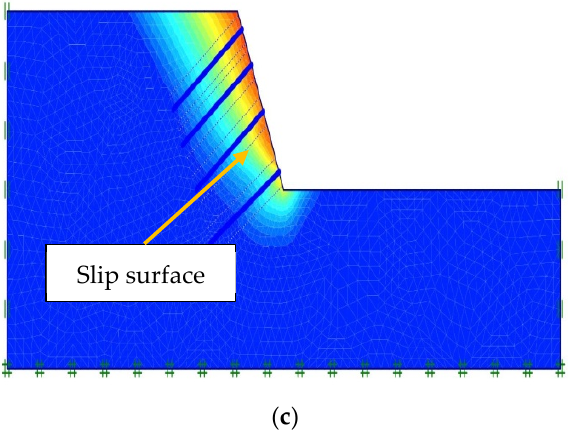
Figure 6. Numerical model of analysis for soil with various nail inclinations: ( a ) horizontal nail, θ = 0° ( b ) θ = 20°, and ( c ) θ = 30°.